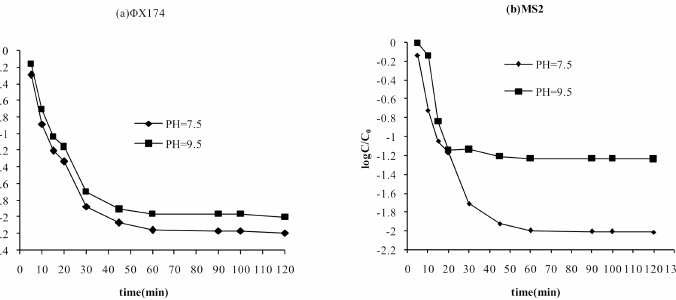
Figure 4. pH against adsorption of ( a ) Φ X174 and ( b ) MS2 (expressed as logC/C 0 ).